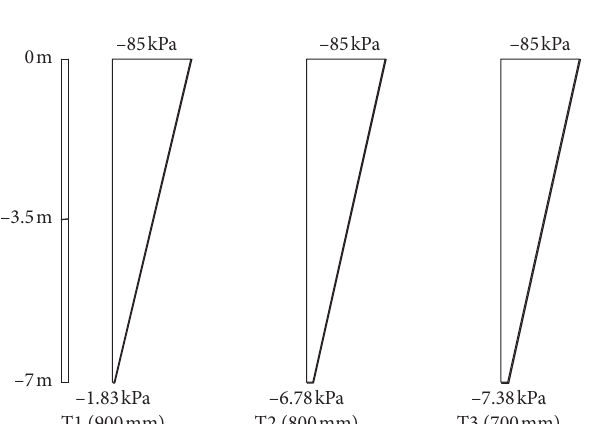
Figure 10: (a) Consolidation rate; (b) Average degree of consolidation.